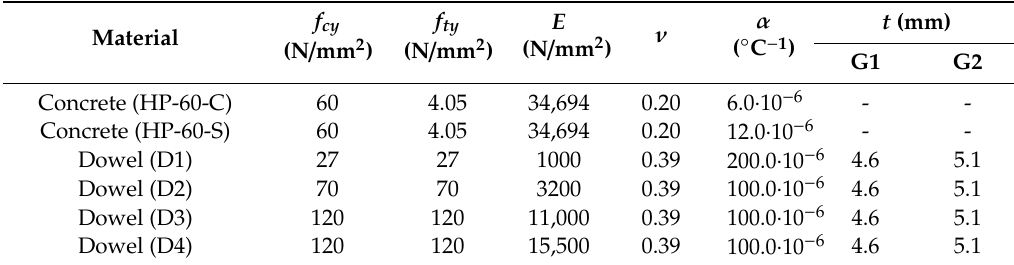
Table 3. Properties of the two types of concrete (C and S) and the four dowels.